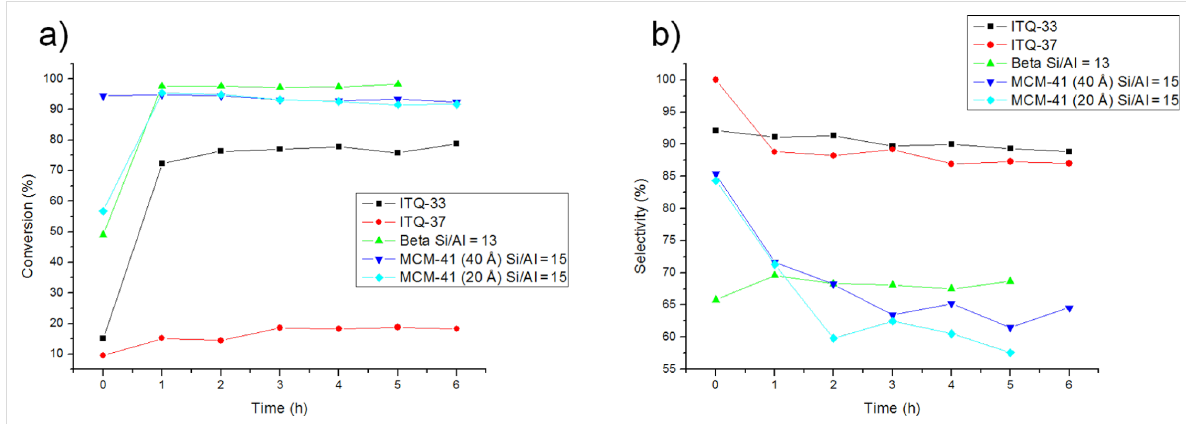
Figure 5: Comparison of conversion (a) and selectivity (b) of the DAR catalysed extra-large pore 3D zeolites.